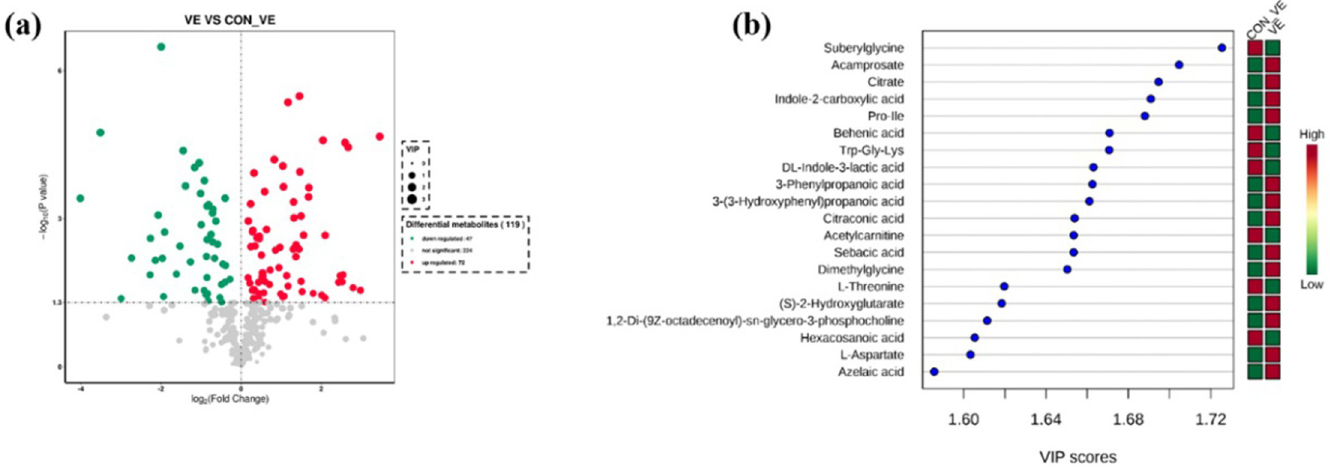
Fig 5. Differential metabolites in serum samples before and after VE injection in yak. (a) Volcano plots of the difference metabolites. Each point in the volcanic map represents a metabolite, red and green dots indicate up-regulated and down-regulated metabolites respectively. Metabolites with no difference are shown in gray. (b) Metabolites are ranked by variable importance in projection analysis (VIP) of respective groups. The top 20 important metabolites were arranged from top to bottom according to intracellular concentration. The red box represents a high concentration of the molecule and the green box represents low concentration.